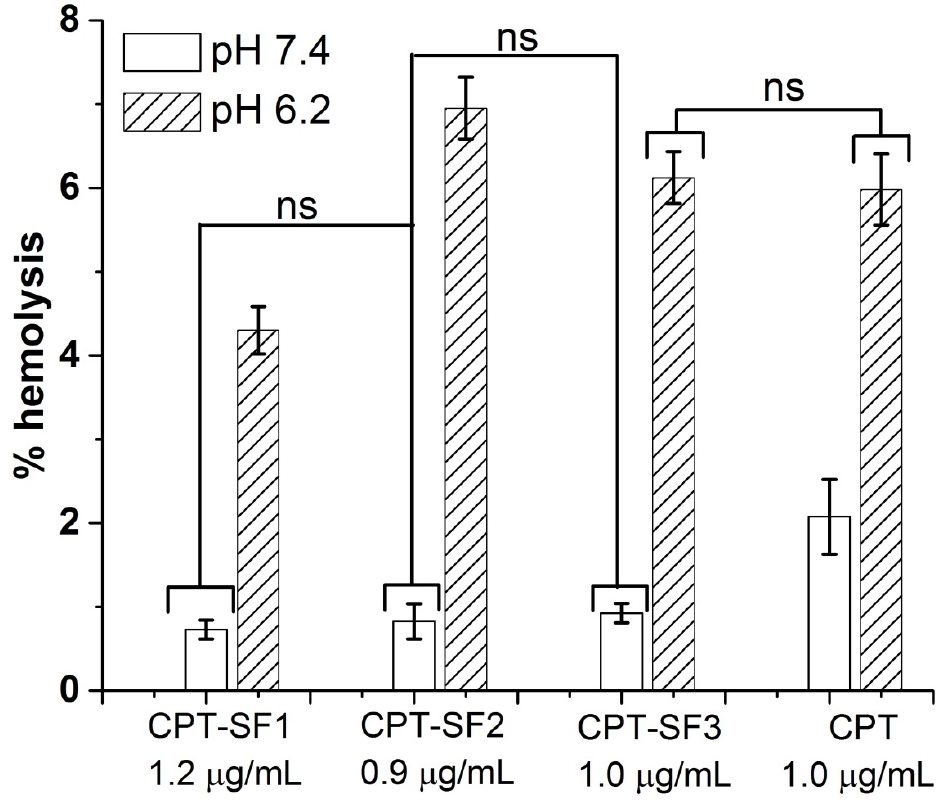
Figure 6. Percentage of hemolysis of RBC treated with CPT-loaded SF nanoaggregates and parent CPT in PBS at pH 7.4 and 6.2 (see structures in Figure 1). Mean ± standard deviation ( n = 3). ns represent means with no significant differences ( p > 0.05), but significant differences exist between non-marked bars ( p < 0.05).